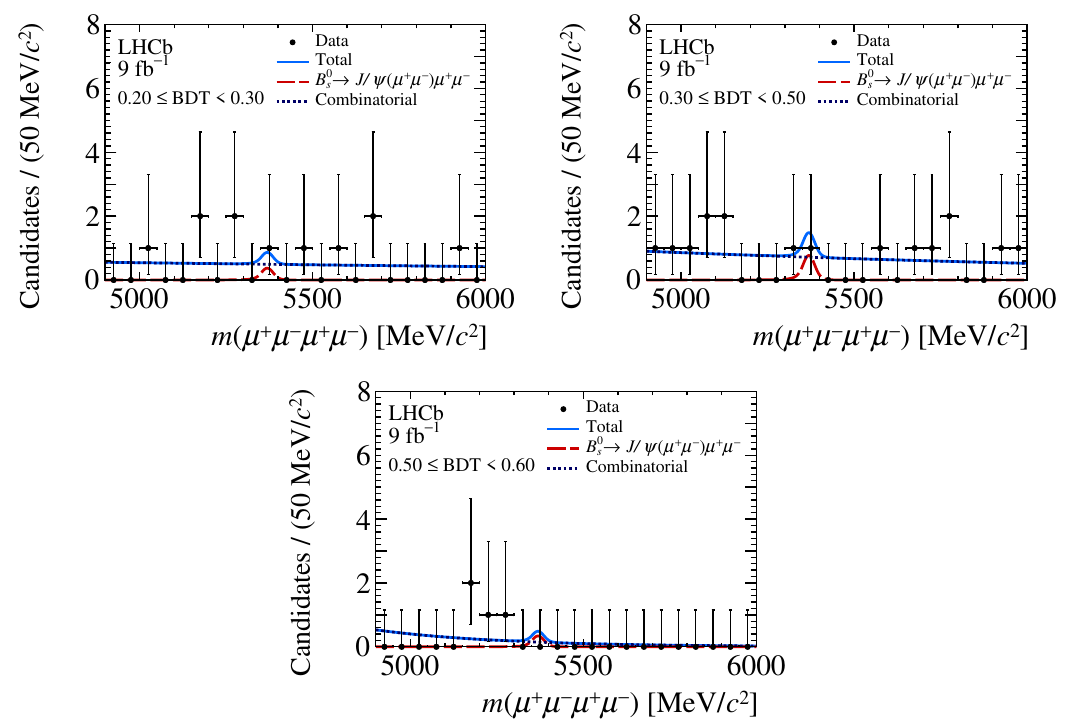
Figure 10 . Distribution of the µ + µ − µ + µ − invariant mass of candidates passing the B 0 → J/ψ ( µ + µ − ) µ + µ − selection in (top left) the lowest BDT interval, (top right) the second ( s ) lowest BDT interval and (bottom) the second highest BDT interval, with the fit models used to determine the branching fraction of B 0 → J/ψ ( µ + µ − ) µ + µ − s